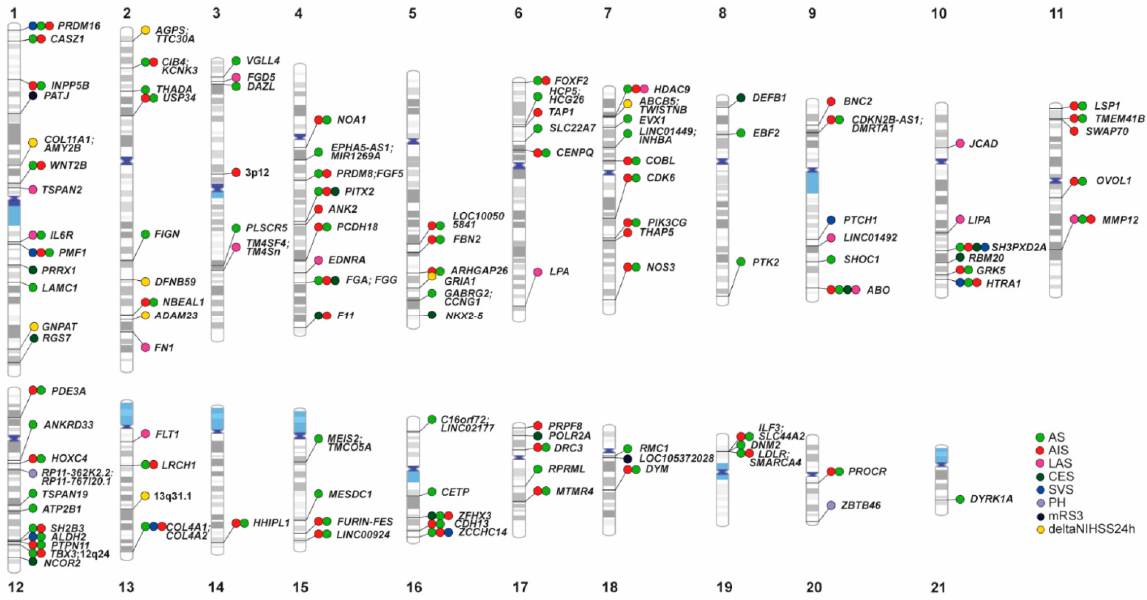
Figure 1. Genetic loci influencing stroke phenotypes. Ideogram of genomic regions influencing stroke phenotypes; colored circles represent genome-wide significant loci in published studies. Colors correspond to associated stroke phenotypes (green, AS: All Strokes; red, AIS: All Ischaemic Strokes; pink, LAS: Large-artery atherosclerosis Stroke; dark green, CES: Cardioembolic Strokes; blue, SVS: Small Vessel Stroke; purple, PH: Parenchymal Hematoma; black, mRS3: modified Rankin Scale three months after stroke; yellow, deltaNIHSS24 h: difference between NIH stroke scale (NIHSS) within six hours of stroke onset and NIHSS at 24 h. Prioritized genes in the original publications are